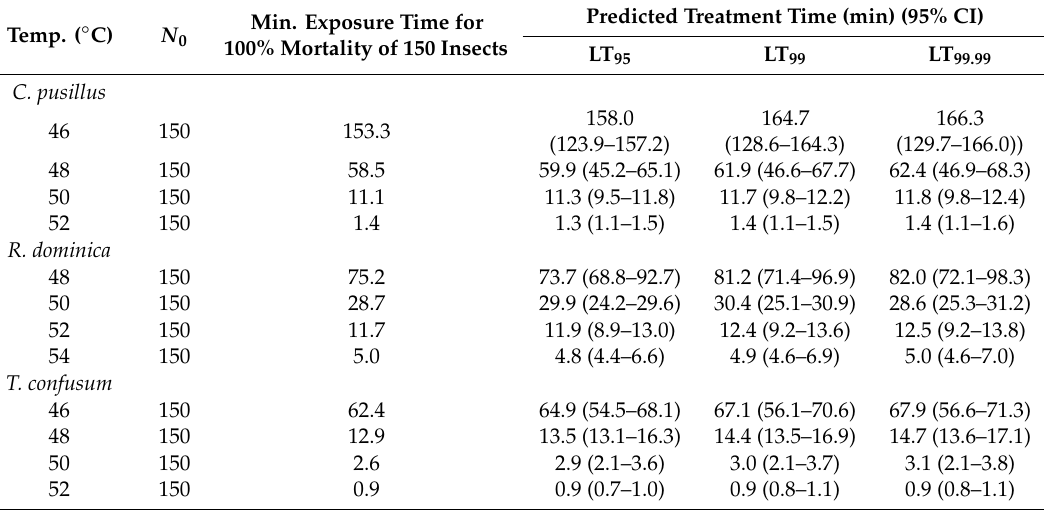
Table 3. Comparison of LTs (min) obtained by experiments and predicted by 0th-order kinetic models for adult C. pusillus , R. dominica , and T. confusum at four di ff erent temperatures. Temp. ( ◦